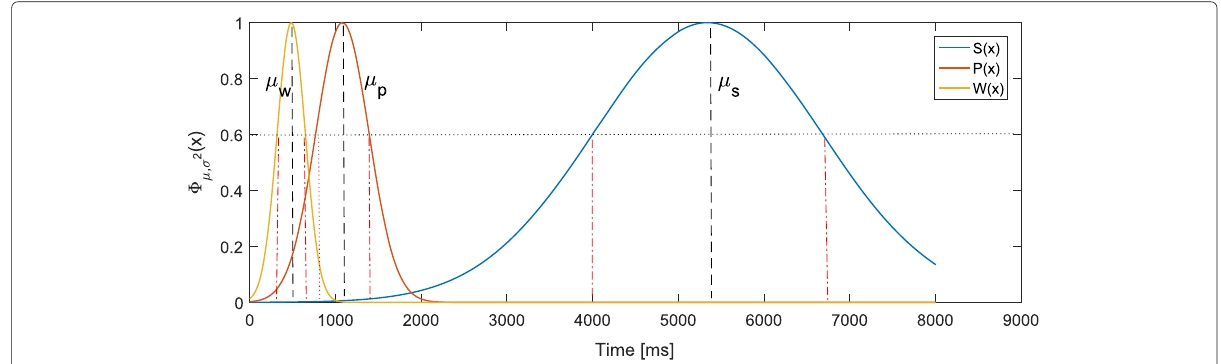
Fig. 3 Gaussian distributions of duration in sentence, phrase, and